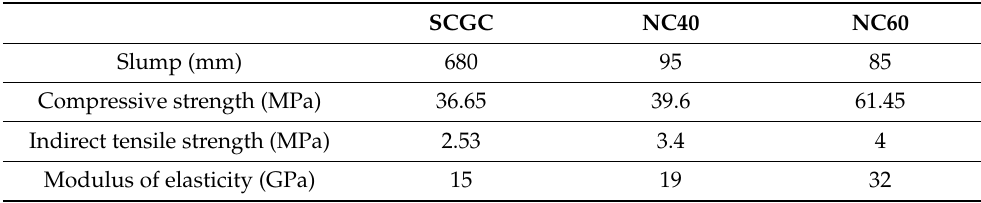
Table 6. Concrete mechanical